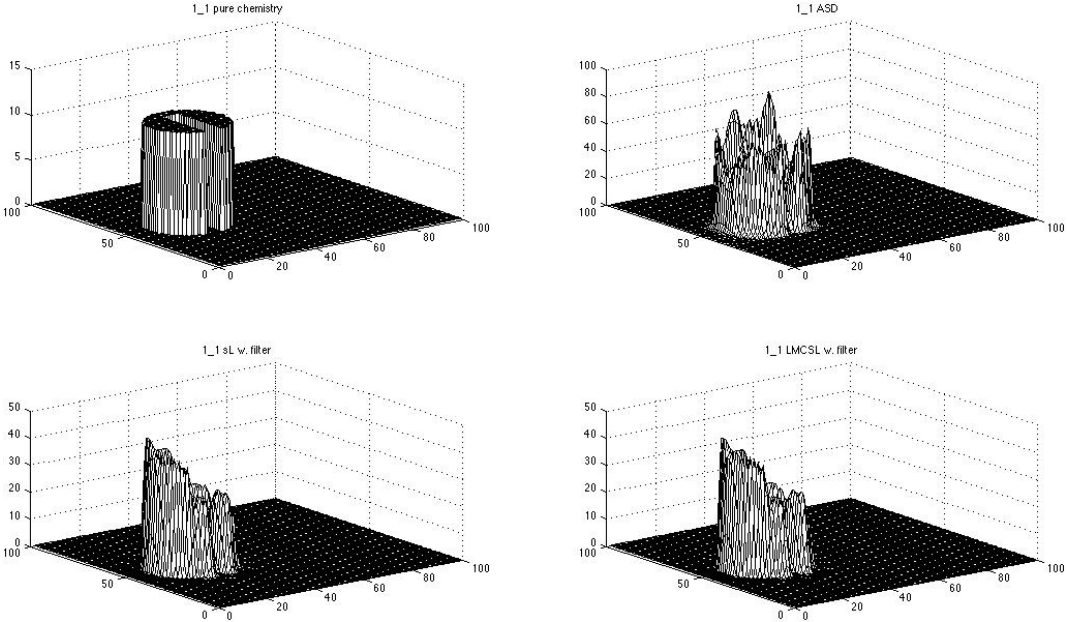
Fig. 9. Slotted cylinder, NO 2 , 1t = 90s, 1x = 1 . 0, C = 0 . 327 Rotation test with the slotted cylinder for NO 2 using urban chemistry and resolution 1 1, with 1t = 90s, 1x = 1 . 0, and C = 0 . 327. The results are given for pure chemistry (top left) and chemistry and advection using ASD (top right), using semi-Lagrangian interpolation with filter (bottom left), and using LMCSL with filter (bottom right). Note, the vertical axis on the top left plot is the interval 0–15, whereas the top right is in the interval 0–100, and the two bottom plots are in the interval 0–50. The minimum and maximum values for the respective plots are: Top left: min=0.1317, max=11.36. Top right: min=0.0016, max=89.15. Bottom left: min=0.0056, max=48.21. Bottom right: min=0.005,